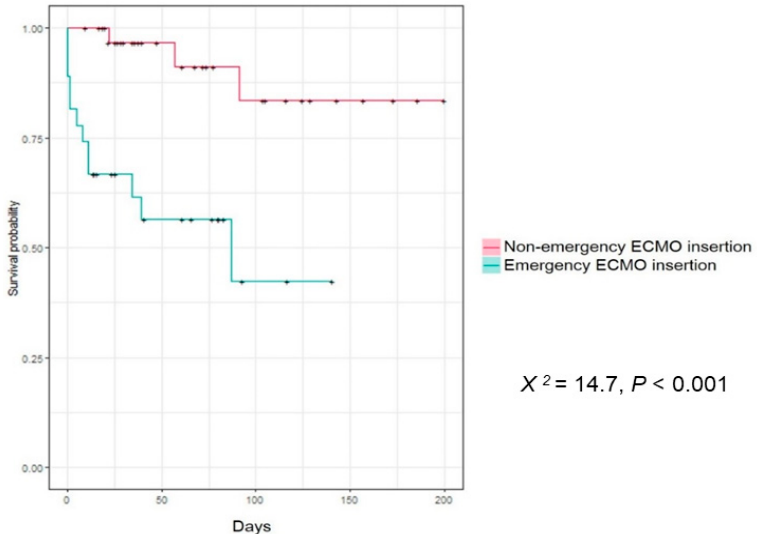
Figure 2. Kaplan – Meier analysis for 30 days mortality according to the timing of ECMO. Kaplan– Meier analysis for 30 days mortality according to the timing of ECMO in emergency EMCO group and non-emergency ECMO group. Emergency ECMO group had a significantly higher 30 days mortality ( X 2 = 14.7, p < 0.001). mortality ( X 2 = 14.7, p <